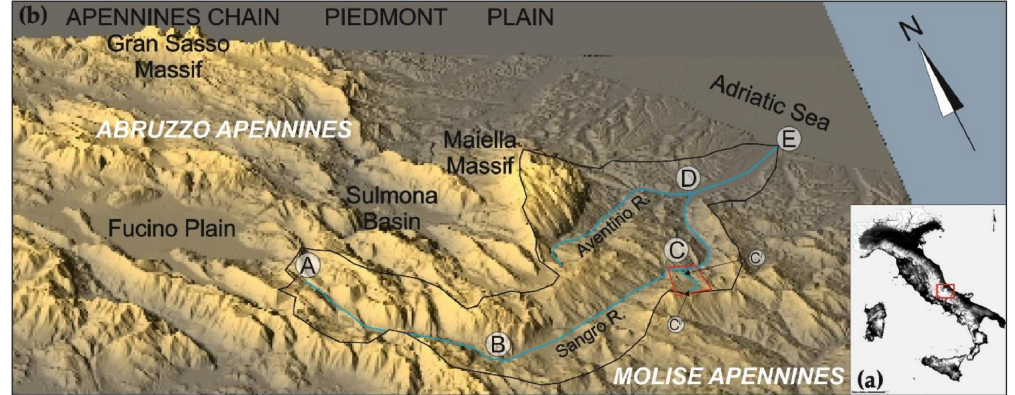
Figure 1. ( a ) Location map of the study area in Central Italy. ( b ) 3D view (from 90 m DEM, SRTM) of the Abruzzo–Molise region. Letters A, B, C, D, E outline key point of the Sangro River (i.e., main river bend and knick points); Letters C’ and C” outline key point of the Verde Stream. In blue: the drainage network; in black: the drainage basin of the Sangro River; the red box frames the drainage basin object of this study (modified from